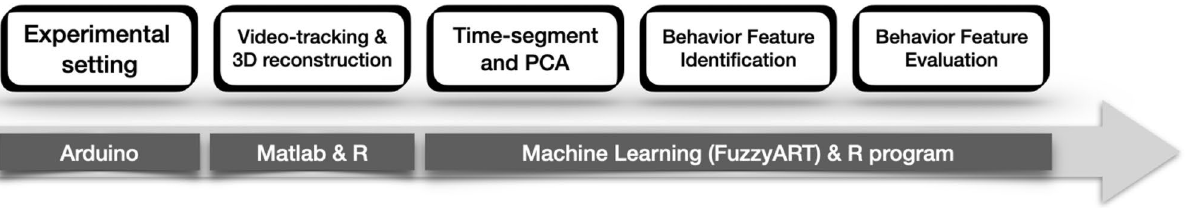
Figure 1. Flowchart illustrating the experimental strategy of this study. The experimental workflow included recorded novel tank test behaviors across treatments and trials. A video-tracking analysis was performed and 3D swimming path reconstruction was performed by using customized MATLAB and R software. Time- segmentation and dimensionality reduction of the 3D spatiotemporal data were performed by a principal component analysis (PCA), followed by unsupervised clustering by using customized machine learning algorithms (FuzzyART) across all behavioral spatiotemporal data to identify potential behavior features linked to treatment. Finally, a behavior feature evaluation was performed with the trained model and new input data.